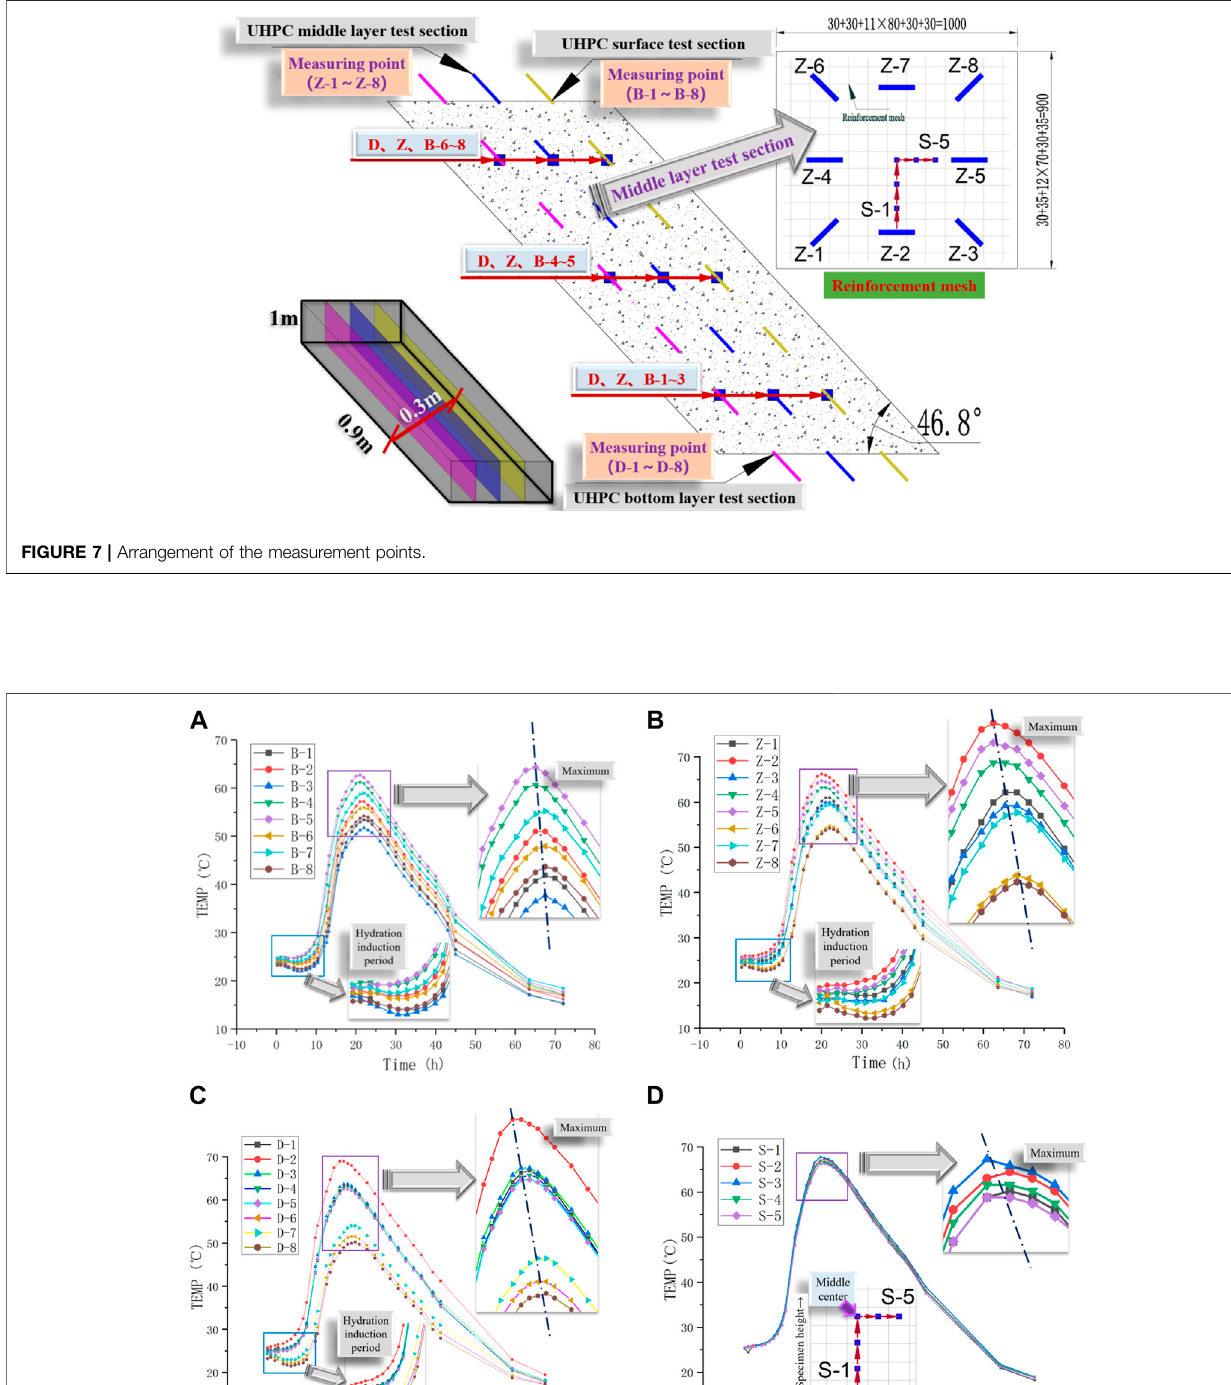
Frontiers in Materials |